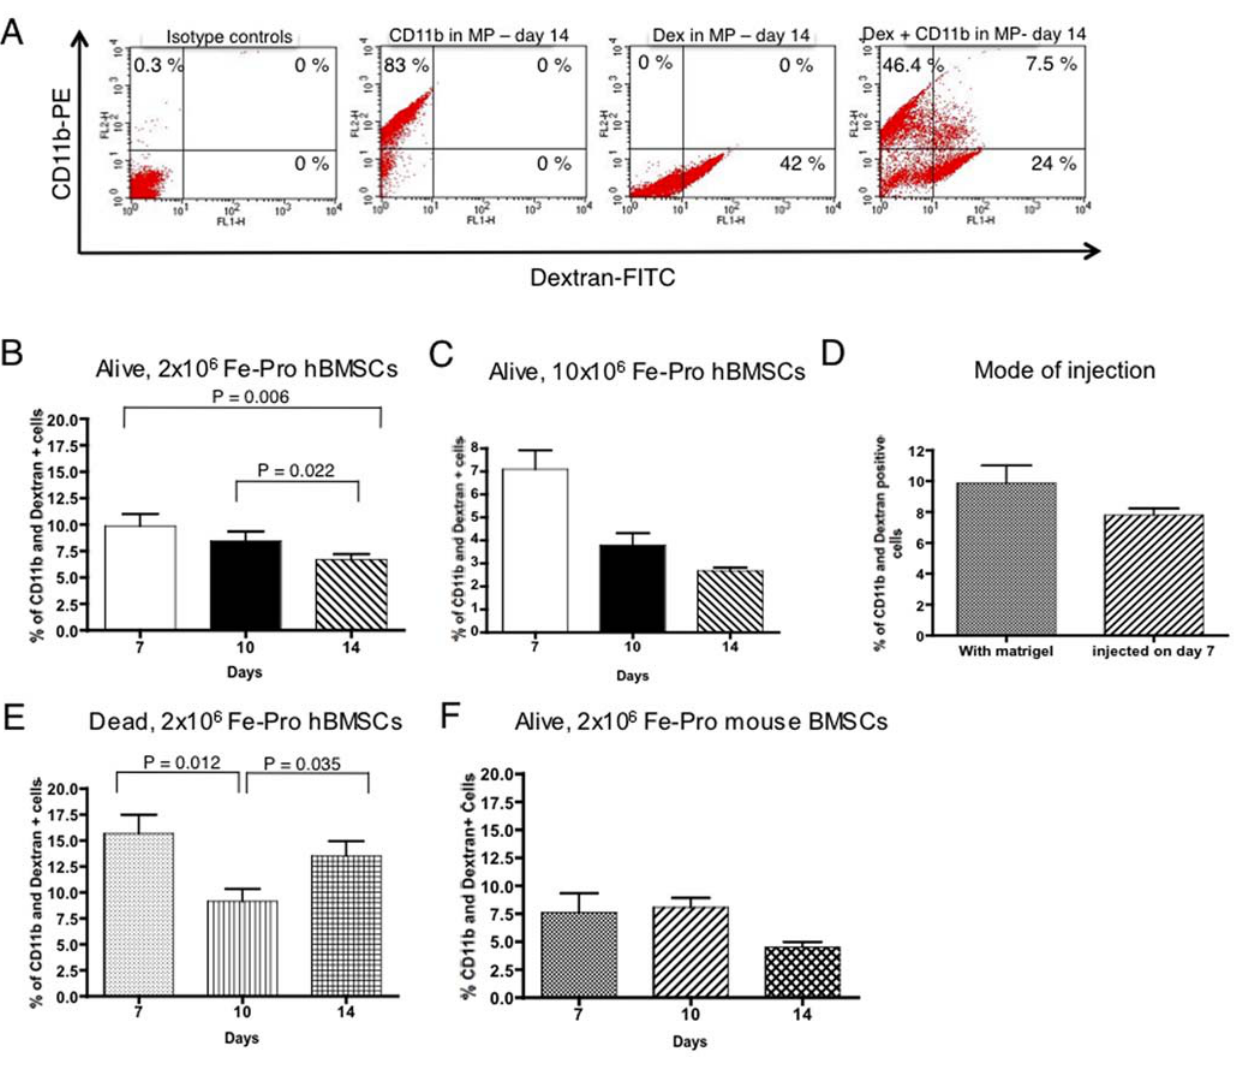
Figure 6. Fe-Pro uptake by local infiltrating Matrigel TM plaque macrophages from Fe-Pro-labeled BMSCs. Representative flow cytometry plots showing 7.5% of CD11b-PE and Dextran (Dex)-FITC positive macrophages in MPs harvested fourteen days post-implantation (A), Bar graph showing the mean percentage of CD11b + Dex + cells in all MPs collected 7, 10 and 14 days after implantation of MPs containing 2 6 10 6 Fe-Pro labeled live xenogenic hBMSCs (B), 10 6 10 6 Fe-Pro labeled live xenogenic hBMSCs (C), the mean percentage of CD11b + Dex + cells in all MPs containing 2 6 10 6 Fe-Pro labeled hBMSCs and collected on day 7 after implantation as comparted to local injection of 2 6 10 6 Fe-Pro labeled hBMSCs into already vascularized plaque and collecting it 7 days post-injection (D), bar graph showing the mean percentage of CD11b + Dex + cells in MPs collected 7, 10 and 14 days after implantation of MPs containing 2 6 10 6 dead Fe-Pro labeled hBMSCs (E) and 2 6 10 6 syngeneic, live Fe-Pro labeled mouse BMSCs (F). Note similar levels and a gradual decrease of Fe-Pro uptake by macrophages after implantation of live xenogenic Fe-Pro-labeled hBMSCs or syngeneic mouse Fe-Pro labeled BMSCs. The uptake of Fe-Pro by macrophages from dead Fe-Pro labeled hBMSCs was higher as compared to the Fe-Pro uptake from live Fe-Pro labeled